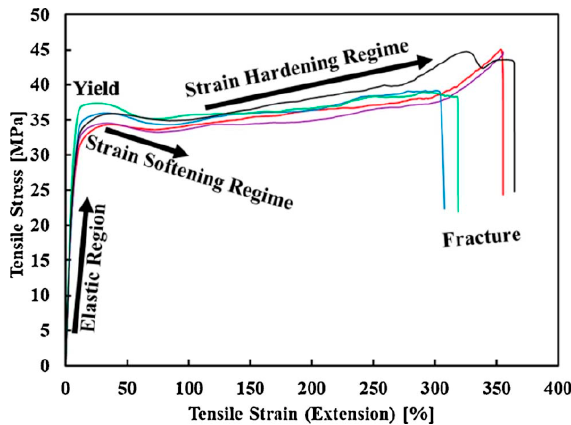
Figure 8. Large-strain hardening of five FFF Nylon6 samples with 100% infill density. Adapted from [136], with permission from © 2018 Elsevier .